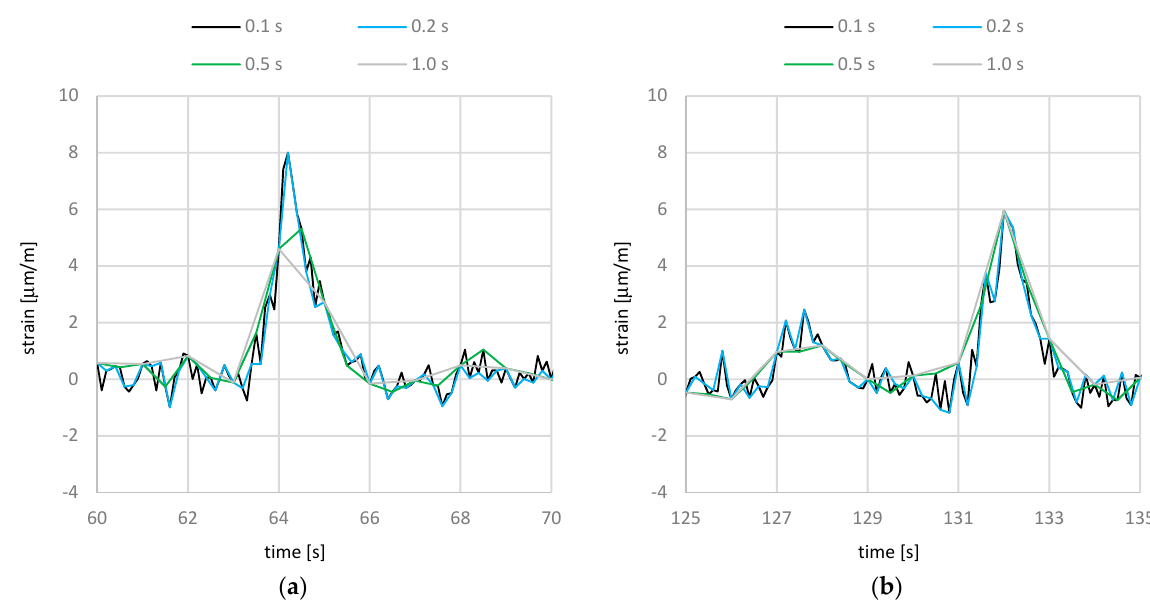
Figure 7. Influence of the sampling rate to the strain measurement over a duration of 10 s at Gerber hinge C: ( a ) time period A from Figure 6; ( b ) time period B from Figure 6.